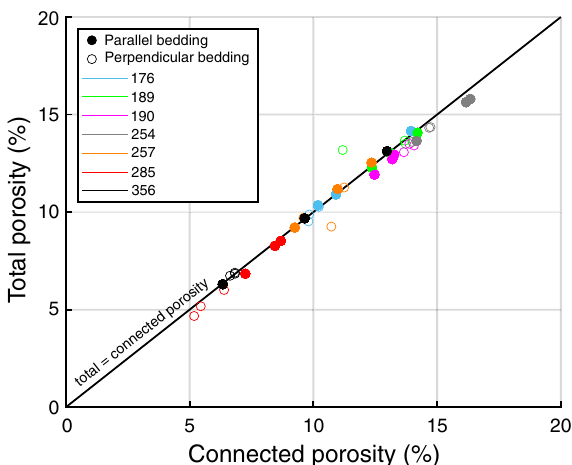
Fig. 6 Total porosity as a function of connected porosity for the 42 samples of Buntsandstein sandstone prepared for this study. Samples were prepared either parallel (filled circles) or perpendicular (unfilled circles) to bedding. The number refers to the box